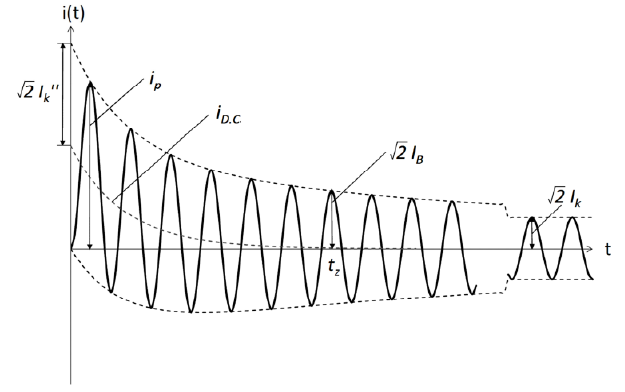
Figure 1. The general course of the short-circuit current [25].